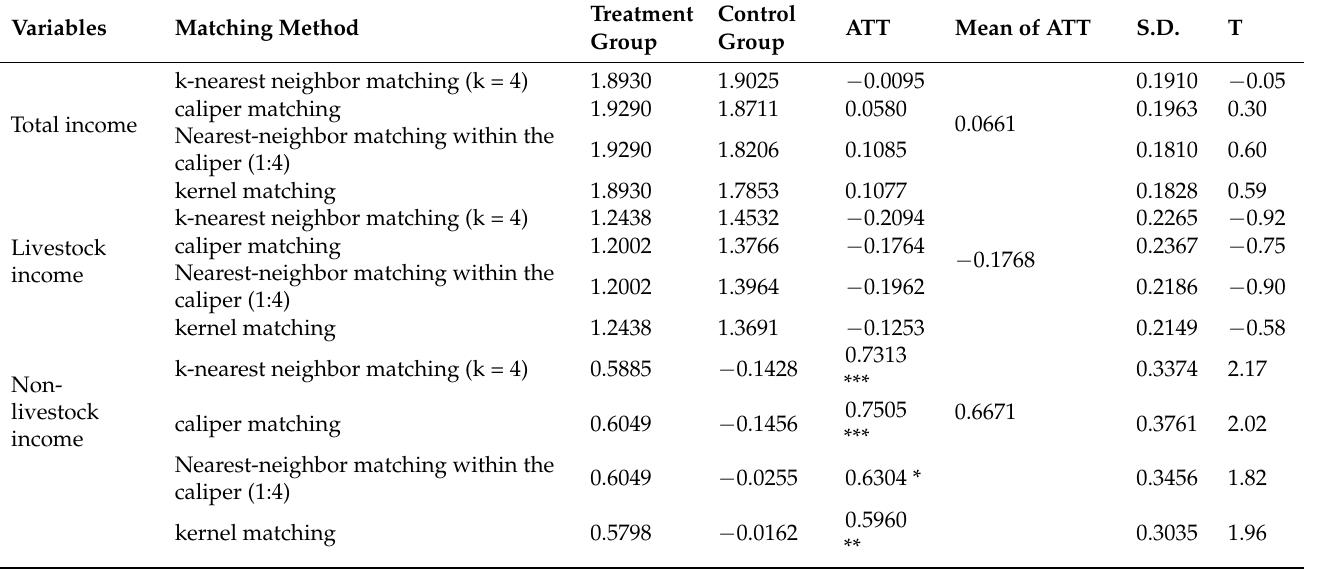
Table 7. PSM results of grassland rent-out on herder